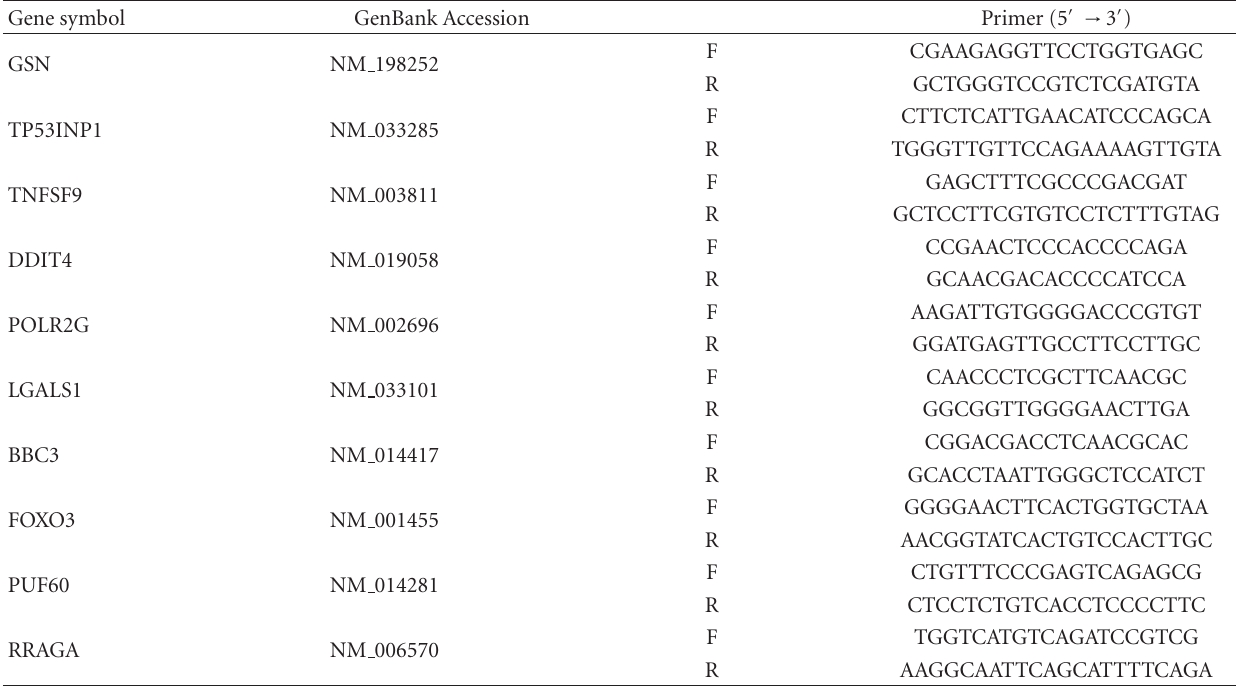
Table 1: Primer pairs for qRT-PCR validation of di ff erentially expressed genes involved in